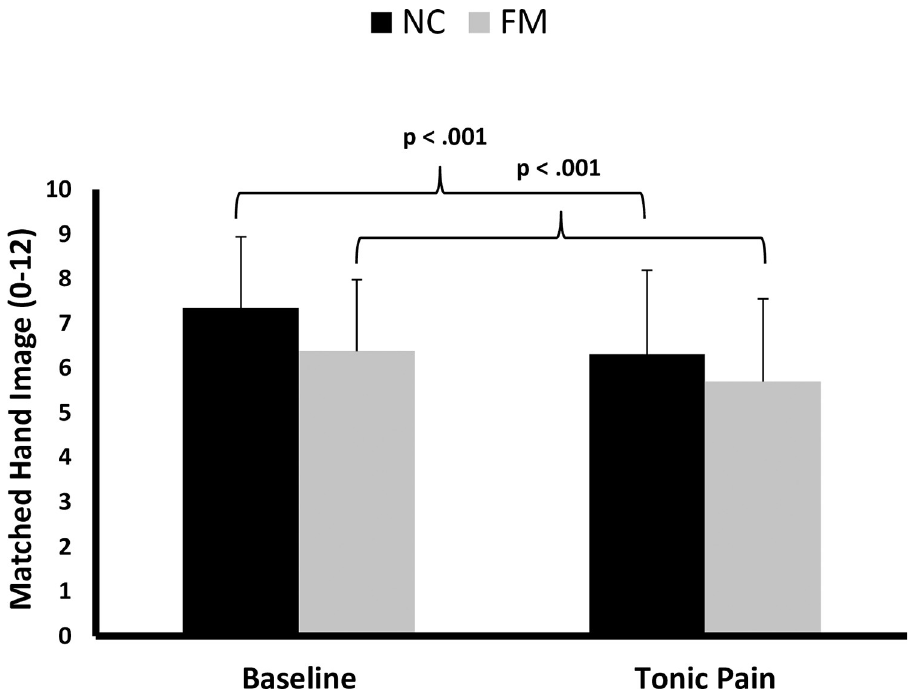
Fig 2. Average (SD) matched hand images by FM participants and HC at baseline and during tonic mechanical pain. While matched hand images of FM participants were significantly smaller than HC at baseline, both groups’ image sizes decreased during application of tonic mechanical pain (p < .001). This change in matched hand images was not significantly different between groups (p > .05).